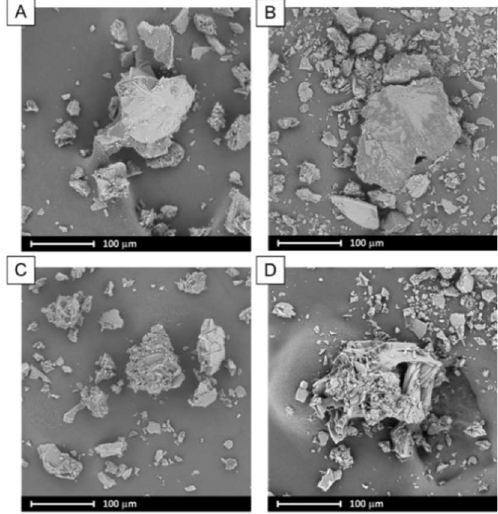
Figure 2. SEM images of binary systems containing bicalutamide and either PLX188 in 1:1 ( A ) and 2:1 ( B ) wt. ratio or PLX407 in 1:1 ( C ) and 2:1 ( D ) wt. ratio obtained using evaporation method.